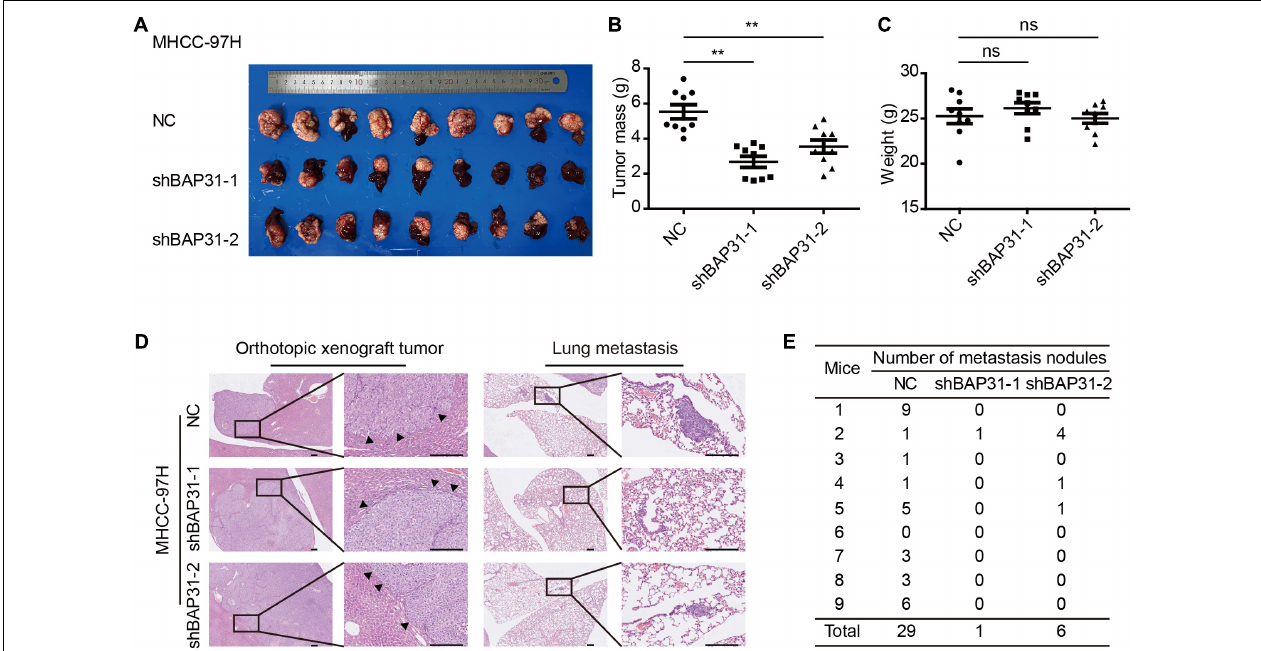
FIGURE 3 | BAP31 promoted HCC progression in vivo . (A–C) Liver orthotopic xenograft experiments injected with shBAP31 and NC group MHCC-97H cells, including the representative images of liver tumors isolated from mice and quantifications of tumor weight and body weight. Results were presented as mean ± SD and t -test was conducted between NC and shBAP31-1/-2 group (ns p > 0.05, ** p < 0.01). (D,E) H&E staining for liver and lung sections acquired from liver orthotopic mouse models, which included the representative images and statistics for the lung metastatic nodules. Scale bar: 200 µ m. Arrows pointed to the margins between tumor and liver